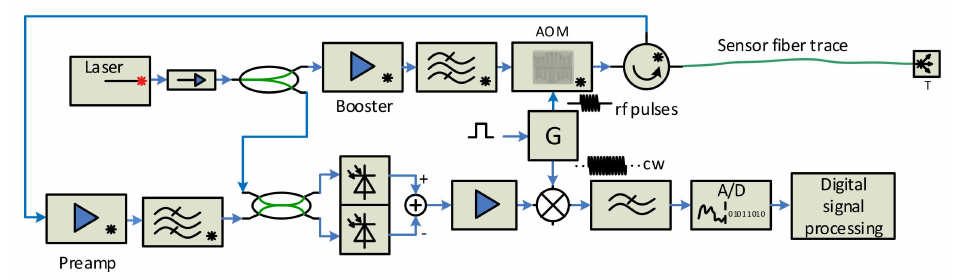
Figure 8. Coherent detection scheme with a single RF signal